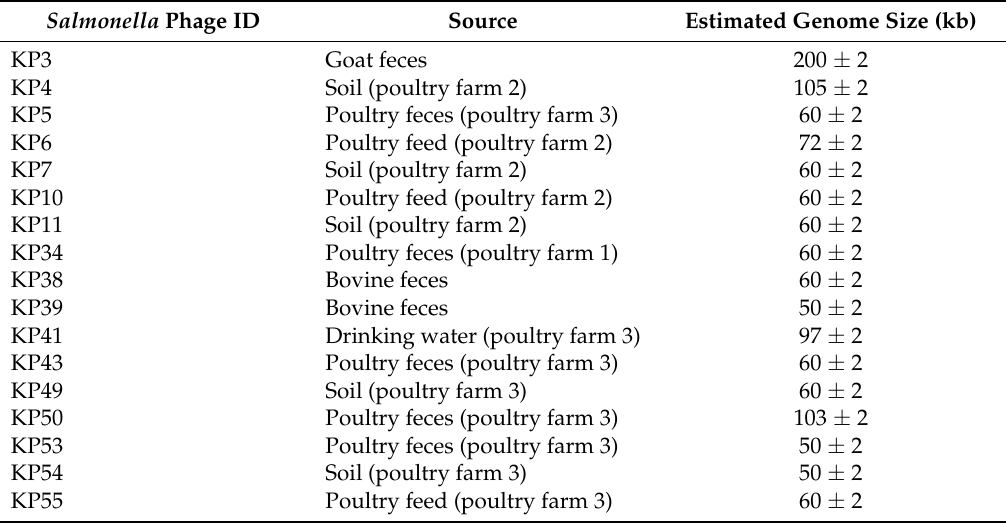
Table 3. Estimated genome size of representative Salmonella phages from various animal farms in this